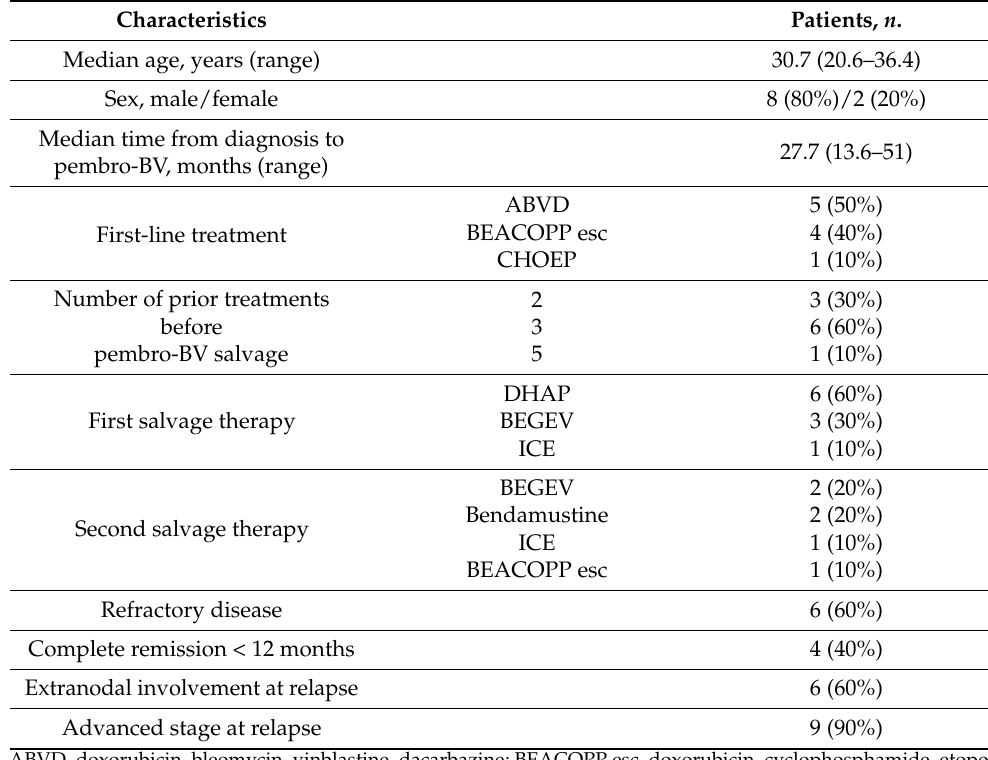
Table 1. Baseline characteristics of patients ( n =